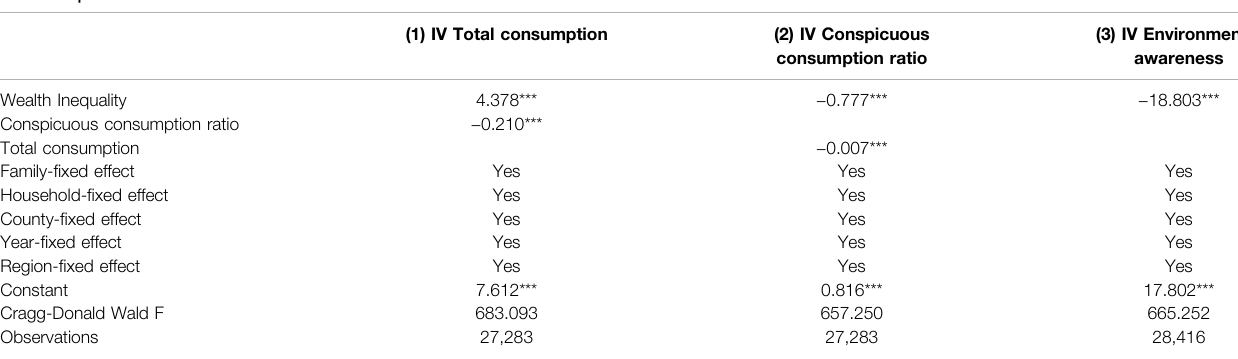
TABLE 4 | Estimation results: IV model for